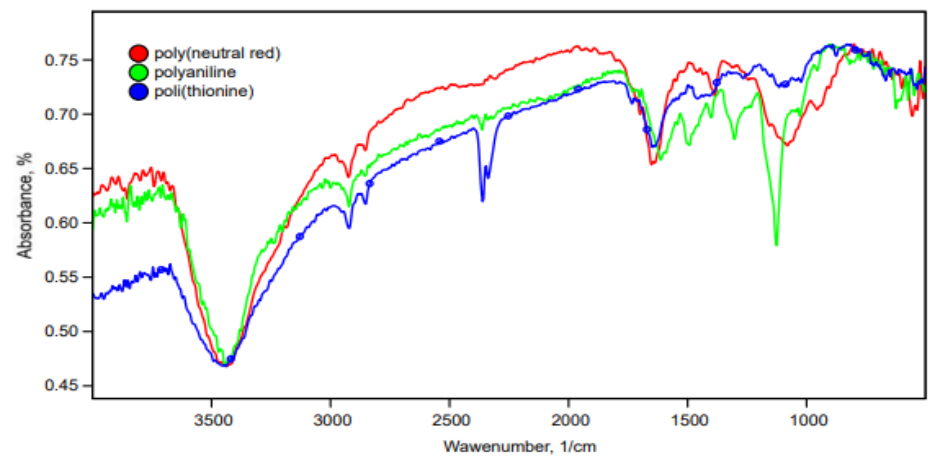
Figure 3. IR spectra of the resulting conductive polymers.